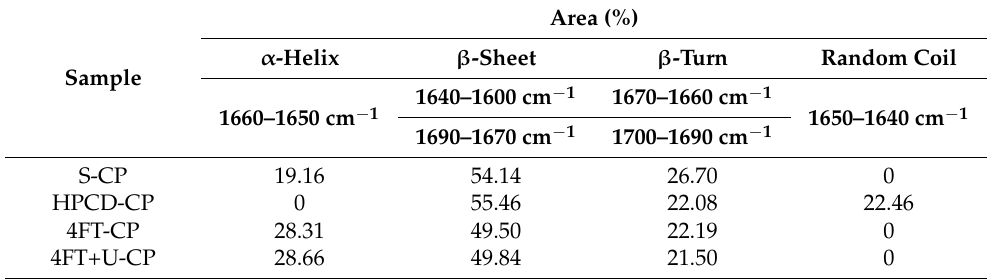
Table 2. Estimation of secondary structure in amide I region of CPs obtained by the different methods. Area (%) α -Helix β -Sheet β -Turn Random Coil Sample